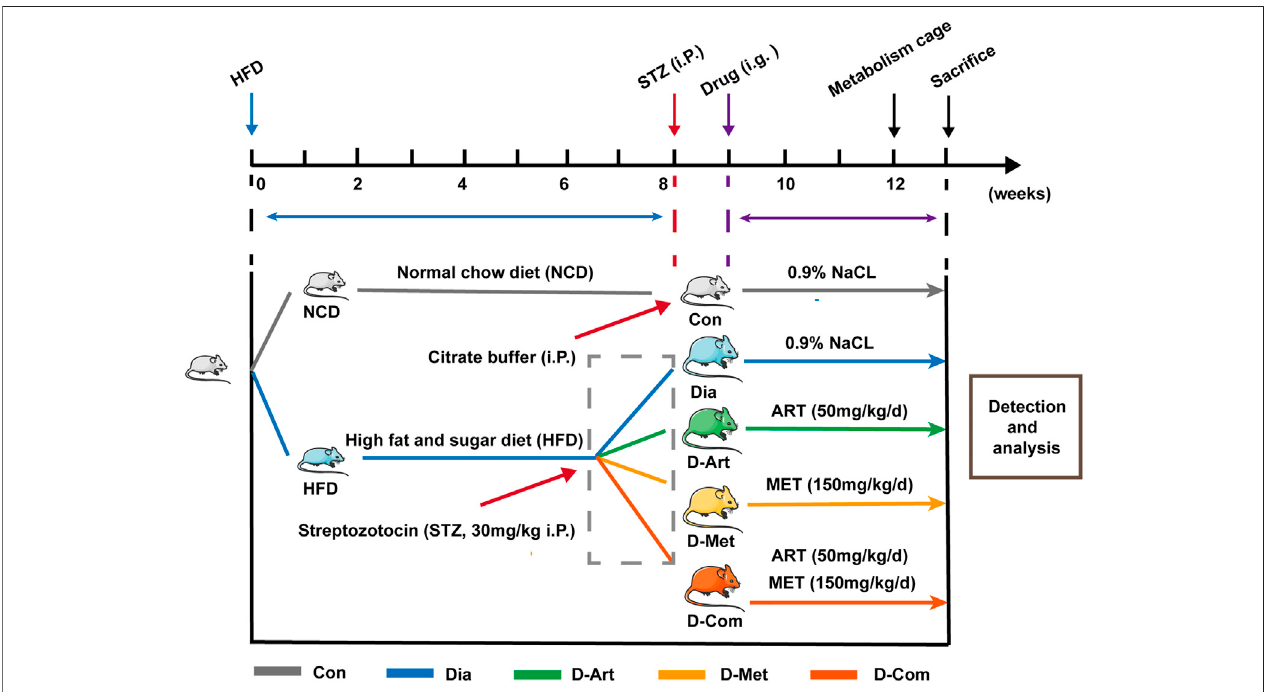
FIGURE 1 | Experimental design. STZ was intraperitoneally injected at 8 weeks after NCD or HFD feeding. Rats with HFD/STZ treatment respectively received intragastric administration of ART, Met, and ART/Met combination for four consecutive weeks at 9 weeks after feeding. Animals were placed in metabolism cages, followedbymeasurementofmetabolicparameters(urine output,foodconsumption, andwaterintake) at 12 weeksafter feeding. Finally,rats weresacri fi cedat4 weeks post drugtreatmentforvariousanalyses.ART,artesunate;Met, metformin. Con, Normalcontrolgroup; Dia,Untreated diabetic group; D-Art, ART-treated diabetic group; D-Met, Met-treated diabetic group; D-Com, ART/Met co-treated diabetic